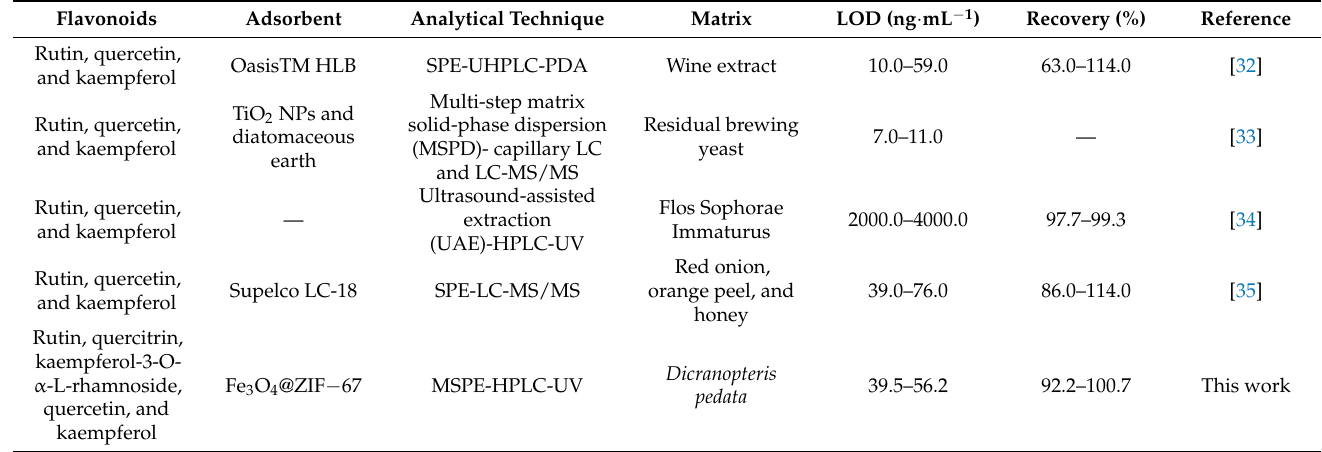
Table 3. Comparison of various methods for the determination of